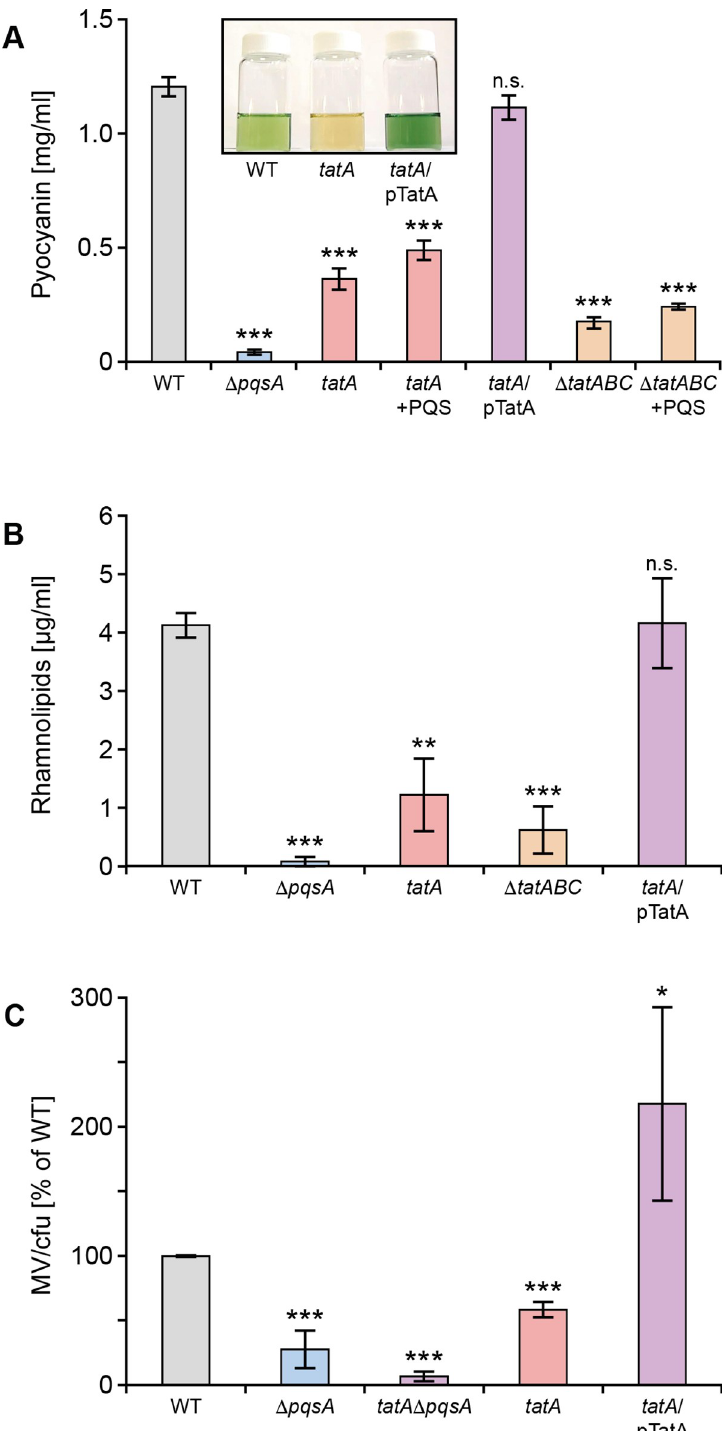
Fig 4. Production of pyocyanin ( A ), rhamnolipids ( B ) and MVs ( C ) are reduced in P . aeruginosa tat mutants. ( A ) Pyocyanin levels are shown in the P . aeruginosa wild type, Δ pqsA , tatA , and tatABC deletion mutants and the tatA mutant complemented with plasmid-borne tatA . The impact of exogenous PQS (40 μ M) on the tatA and Δ tatABC mutants is also shown. Insert panel shows the absence of green pigment in the tatA mutant compared with the wild type and complemented tatA mutant. ( B ) Rhamnolipid production in the tatA and Δ tatABC mutants compared